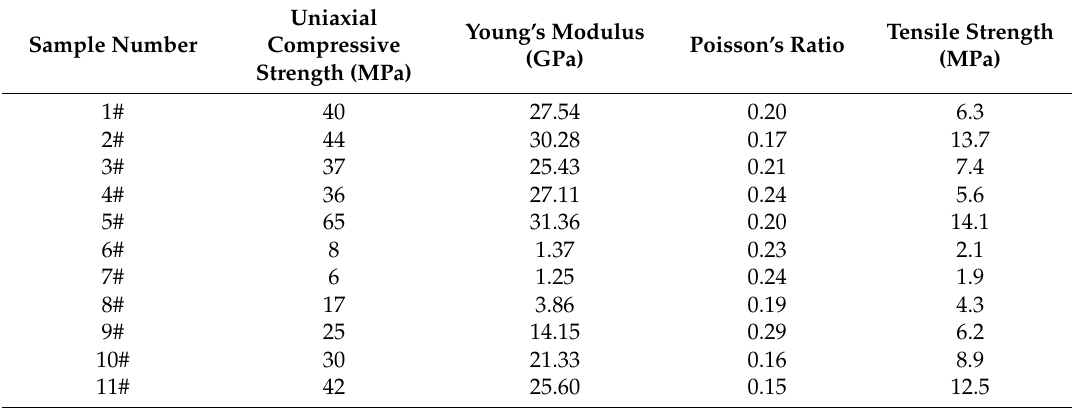
Table 3. The mechanical parameters of marine shales in Niutitang